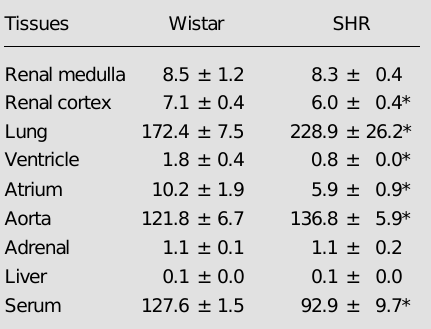
Table 5 - Determination of the ACE activity in several tissues of Wistar and SHR rats. The enzyme activity was assayed as described in Material and Methods. Results are reported as nmol His-Leu min -1 mg protein -1 or nmol His-Leu min -1 ml -1 . Data represent the mean ± SD of three independent experiments. *P<0.05 compared to Wistar rat tissue (Student t